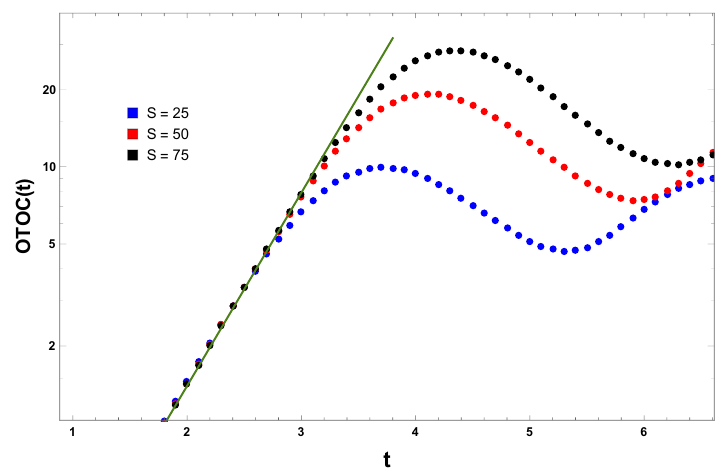
Figure 2. Behavior of OTOC for quantum LMG model (log plot). The OTOC is calculated for spin values S = 25 , 50 and 75 . The early time behavior of OTOCs are fitted to an exponential function ∼ e λ OTOC t . We obtain λ OTOC = 1 . 73446 > λ saddle = on λ OTOC